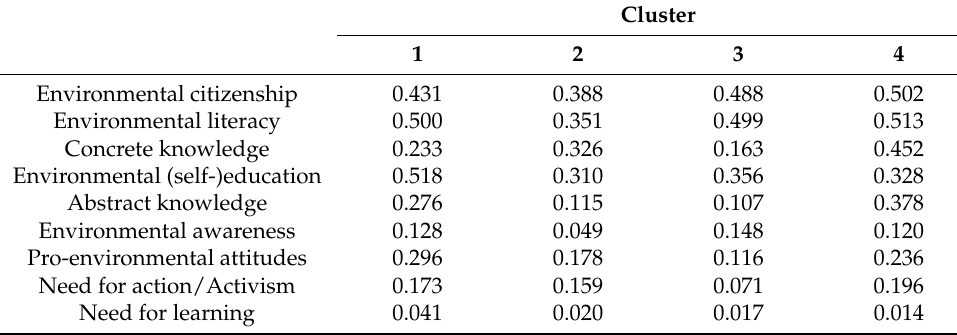
Table 4. R 2 values for each predicted variable among